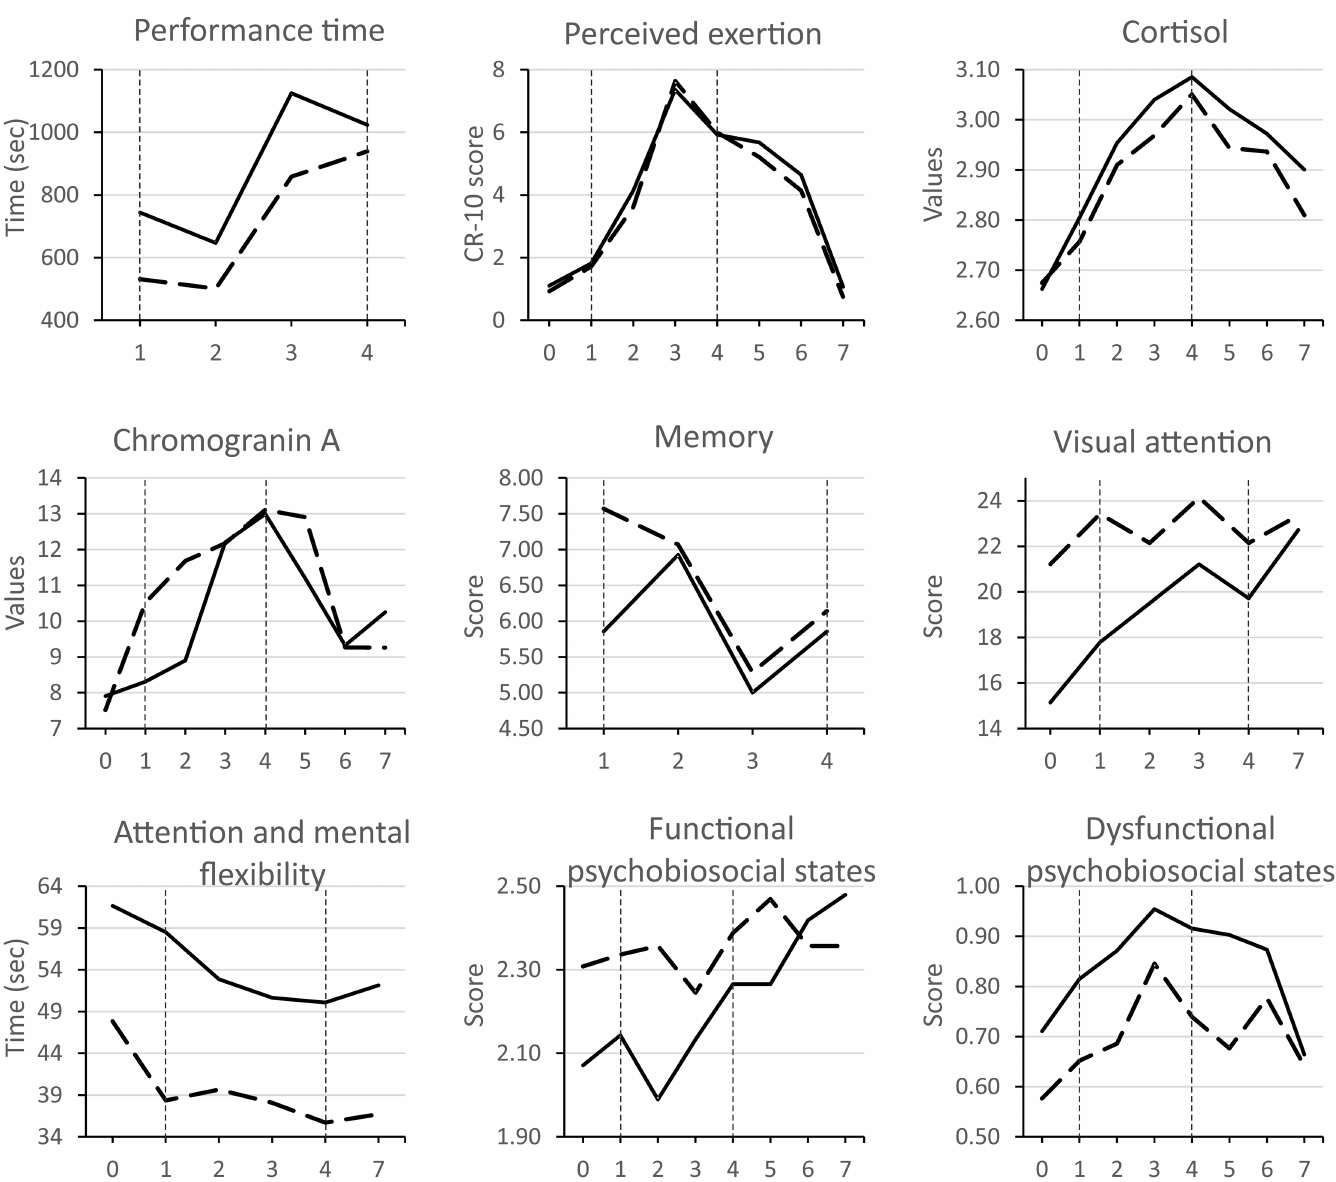
Fig 2. Trend over time of mean variable scores. Solid lines represent the data on the first competitive race, while dashed lines represent the data on the second competitive race. The numbers on the horizontal axis indicate the assessment phase: 0 = 60 min before the race (salivary samples) or just before the race (visual attention and attention/mental flexibility tests); 1 to 4 = after each loop; 5 to 7 = 5 min, 15 min, and 60 min after the race. The first loop and the fourth loop are also marked by vertical-dotted lines. Cortisol and chromogranin A are expressed as